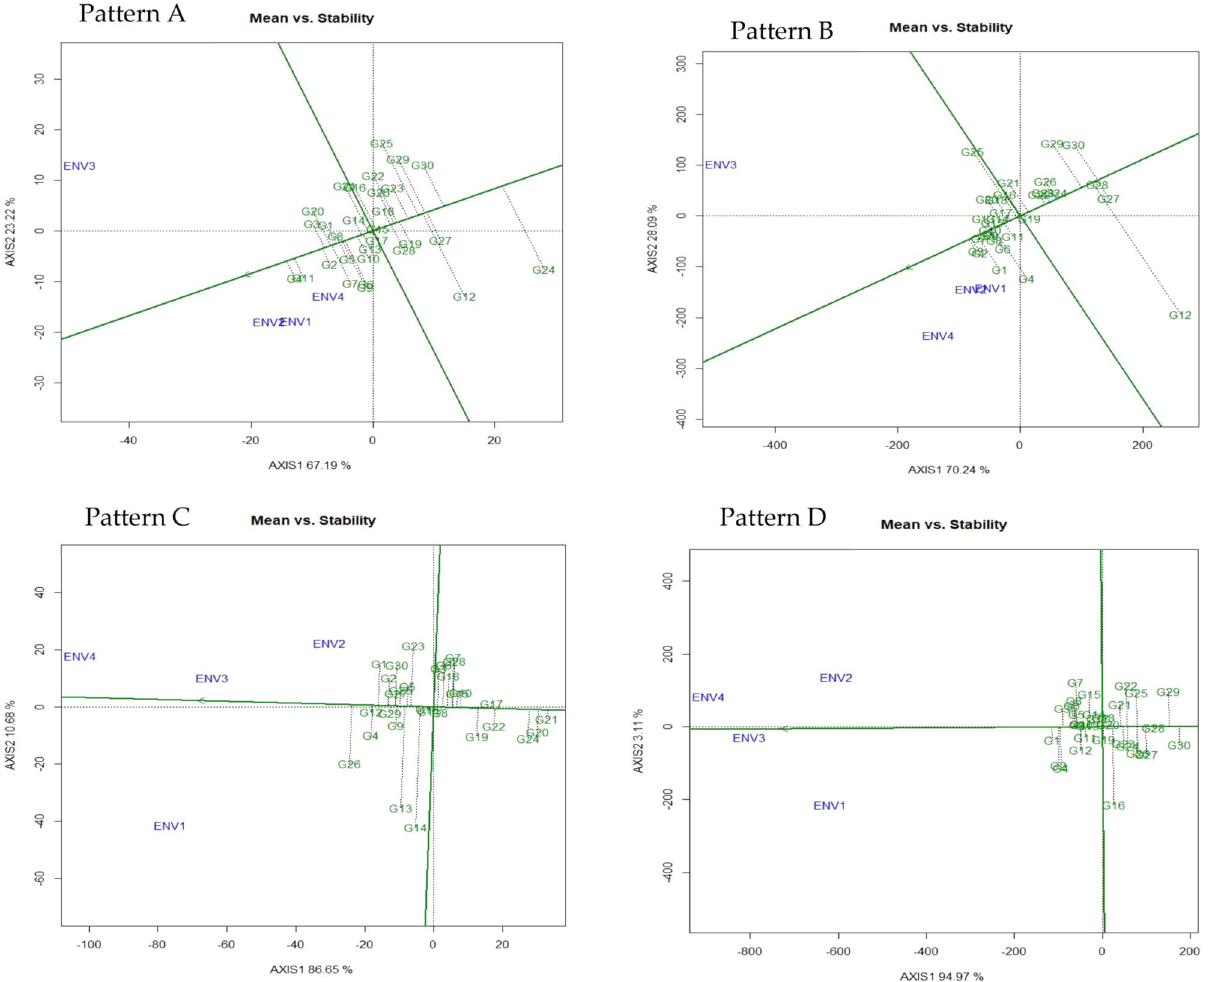
Figure 2. ‘Mean vs. stability’ pattern of GGE biplot illustrating interaction effect of 30 V . subterranea genotypes under two season two location for total number of pods (Pattern A), fresh pod weight (Pattern B), hundred seed weight (Pattern C), yield per hectare (Pattern D). The biplots were created based on Centering = 0, SVP = 2, Scaling = GGE biplot pattern of ‘mean vs. stability’ analysis and ideal genotype assessment. The average environment coordinate (AEC) or average environment axes (AEA) line crosses through the biplot’s origin if SVP = 1 (single value portioning). As a report by Yan and Rajcan 43 , the mean of PC1 and PC2 of the environmental scores is defined. The ‘Mean vs. stability’ view frequently stating to as AEC and SVP that helps to simplify the genotype assessment based on the mean performance and stability under a wide range of environment (Fig. 2). The two straight lines, (i) the AEC abscissa (vertical) and (ii) AEC ordinate (horizontal) comprise this biplot graph. Line one (Fig. 3: Pattern A, B, C, D) consists of a single arrow that pointed towards greater mean performance for each trait. In our investigation, the ‘mean vs. stability’ pattern of GGE biplot revealed 90.41% for total number of the pod (Pattern A), 98.33% for fresh pod weight, 97.33% for hundred seed weight, and 98.08% for yield per hectare of G + G × E variation (Fig. 2). The arrow sign on the AEC abscissa line directed the ranking of geno- types in increasing order with a greater value of traits evaluated. However, genotype G4 produced higher pods followed by G11 and G2 in ENV 1, ENV 2, and ENV 4 while in ENV3, the high pod producing genotype is the G3. For the trait TNP, the genotypes G2 and G8 are more stable over the tested environment though these genotypes produced lower pods (Fig. 2; Pattern A). The highest fresh pod weight (g) was recorded for genotype G2 afterward G3 and G11 in ENV1, ENV 2, and ENV 4 but genotype G13 gave higher FPW in ENV3. Over the environment genotype G7, G10, and G15 leading to highly stable ones with lower performance Fig. 2; Pattern B). In environment one (ENV1) genotype G26 noted for HSW followed by G4 and G12 on the other hand geno- type G1 showed higher HSW in ENV2, ENV 3, and ENV4 though genotype G12 and G29 considered as highly stable across the environment (Fig. 2; Pattern C). In the case of yield per hectare genotype, G1 gave higher yield followed by G2 and G4 in ENV1 and ENV3 whereas genotype G3 followed by G5, G6, G7, and G8 produced maximum yield in the ENV2 and ENV4. Among the accessions, genotype G1, G3, and G5 gave higher yield per hectare and highly stable while G10, G13, G11, G14, G17, G18, and G20 also remarked as more stable genotypes